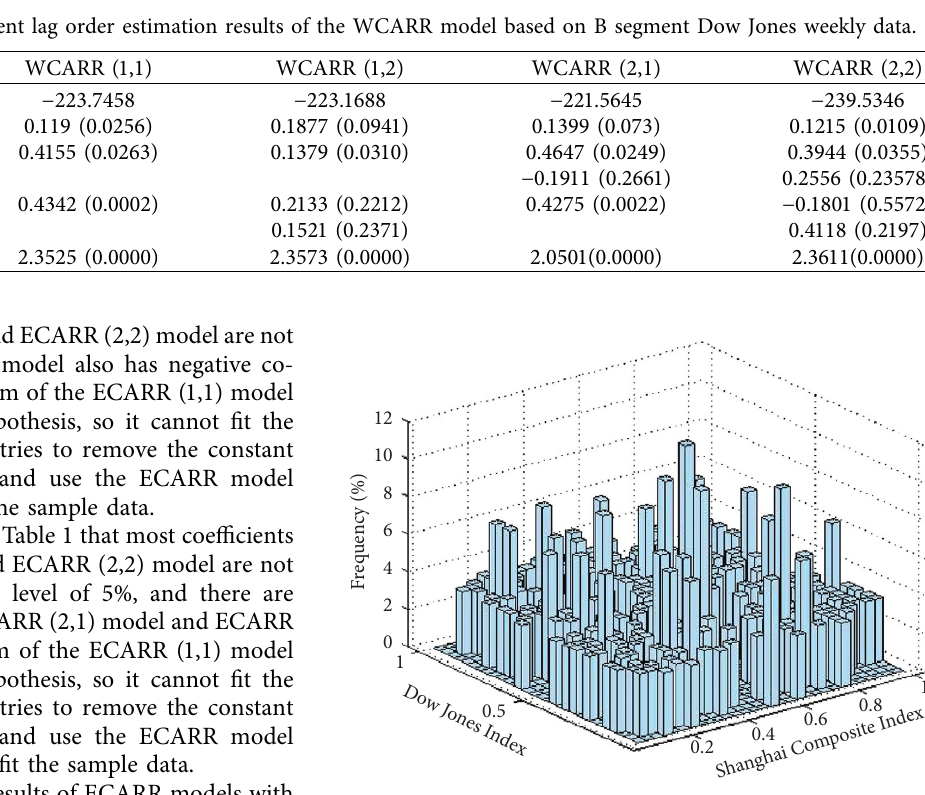
Figure 3: Empirical distribution of SSE index and Dow Jones Index extreme volatility series based on B segment weekly